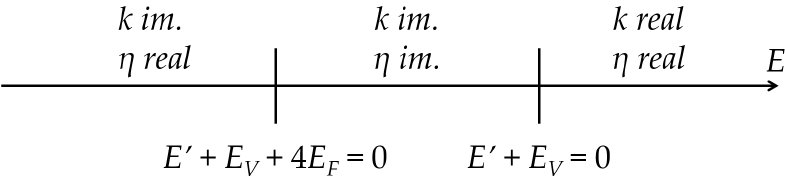
with real, positive and η either real or pure